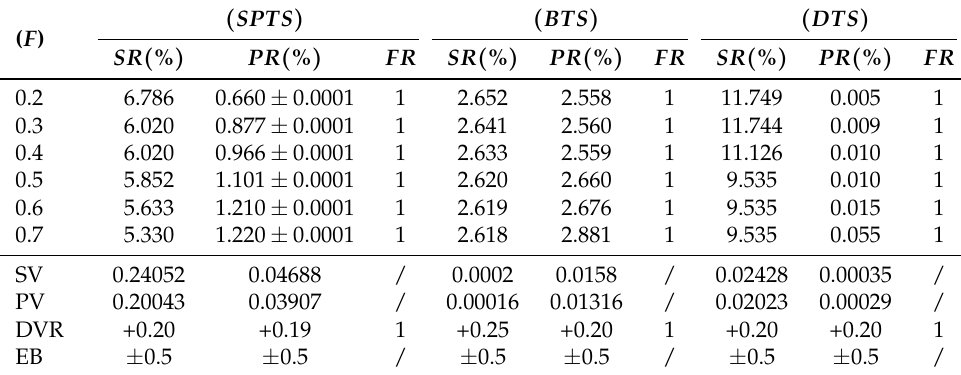
Table 3. Quantum simulation of high-dimensional data tables describing the three topological structures of the DE algorithm implied in β -Hilbert space about F .